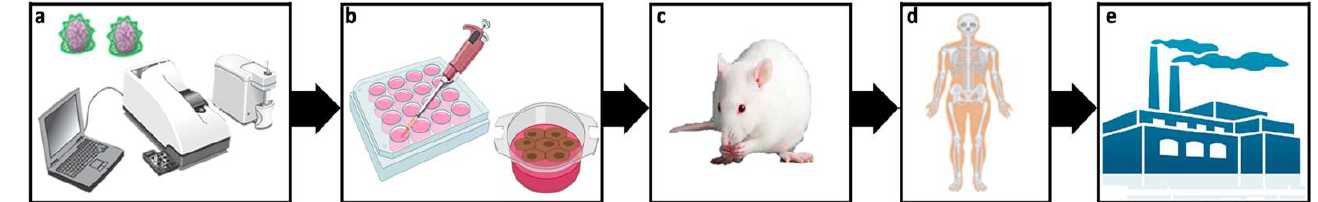
Figure 4. Journey of non-viral vectors from lab to bench. Initially potential non-viral vectors are physicochemically characterized ( a ) before performing both in vitro ( b ) an in vivo ( c ) biological studies. Most promising formulations are further evaluated in clinical trials ( d ). In case of success, the manufacturing process for commercialization starts ( e ).